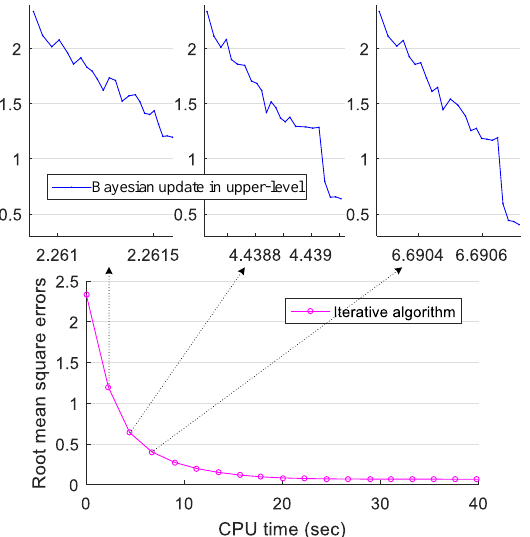
Figure 7. Evolution processes of root mean square errors of traffic